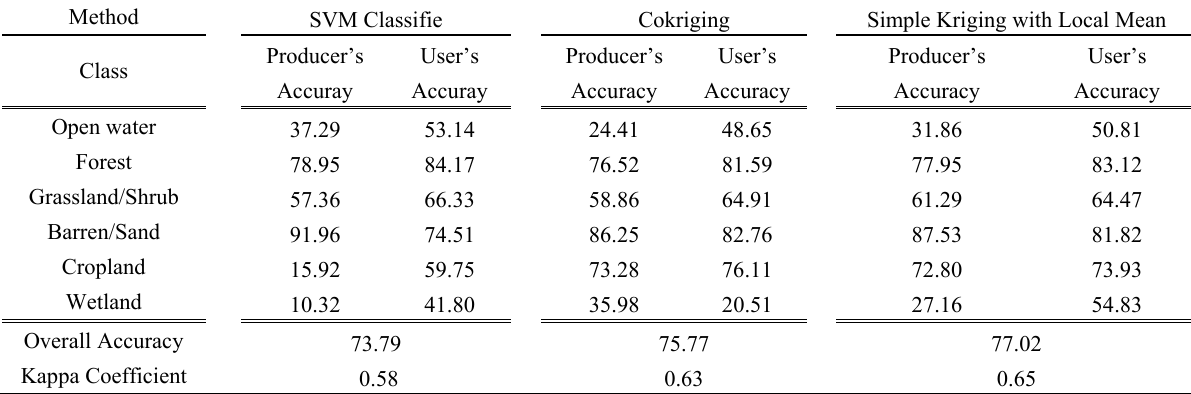
Table 2. Accuracy Assessment Indexes of SVM Classification and Two Kriging Methods (Accuracy Unit: %)